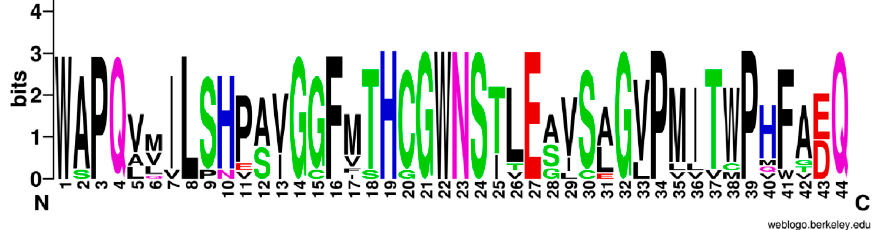
Figure 8. Consensus sequence defining glycosyltransferase plant secondary product glycosyltransferase (PSPG) motif of 18 UDP glycosyltransferases (UGTs) in P. sibiricum . The larger font size the more conserved residues.